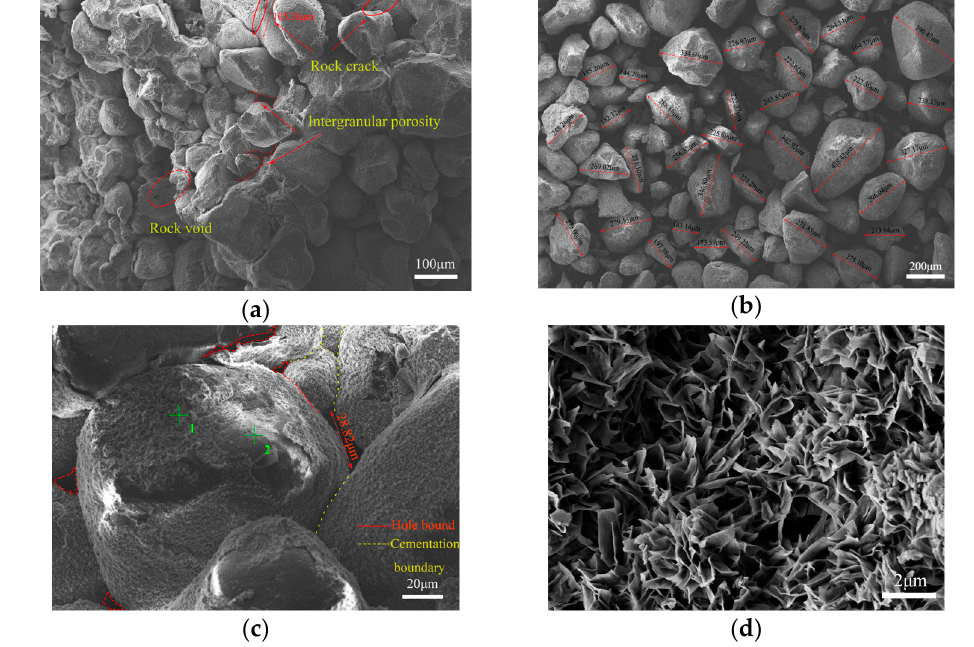
Figure 1. SEM images of rock: ( a ) 100 µm; ( b ) 200 µm; ( c ) 20 µm; ( d ) 2 µm.